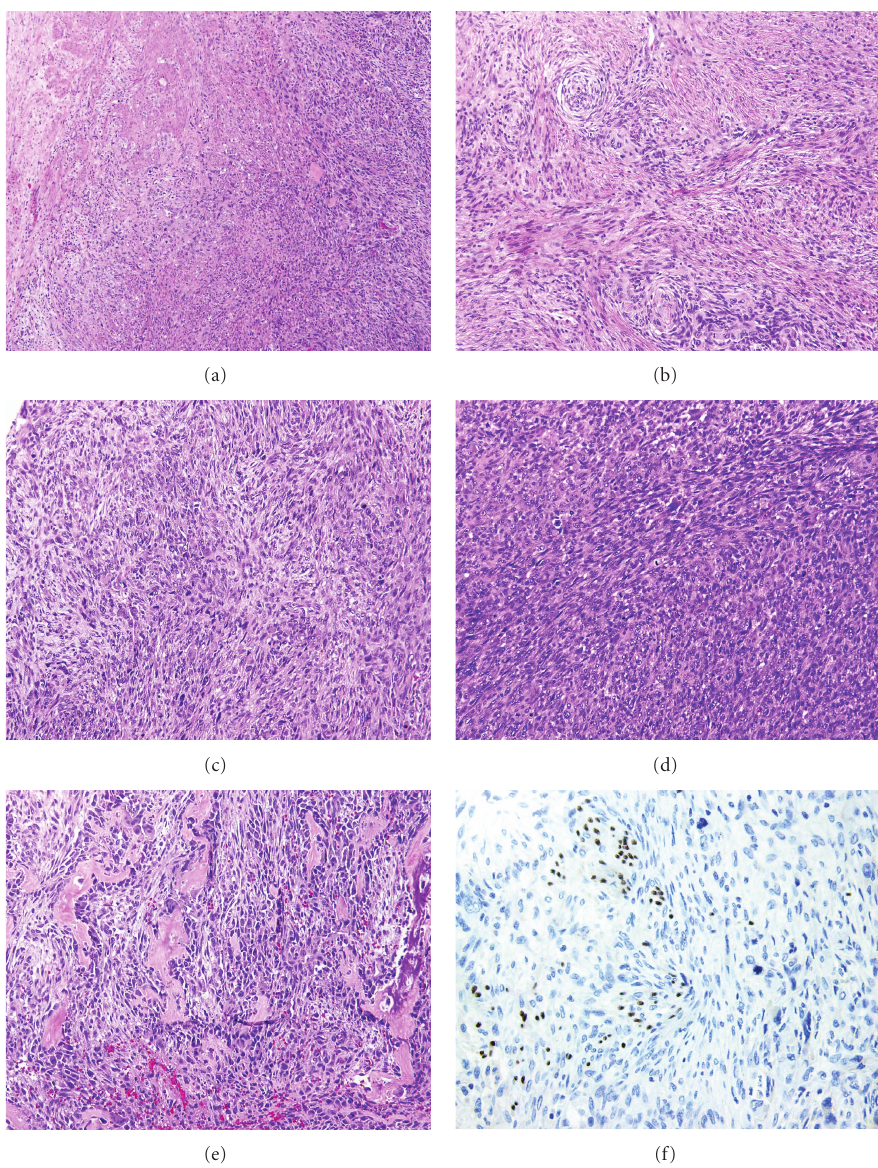
Figure 1: (a) Uterine tumor, areas of transition between the high-grade component (lower right field) and the “leiomyoma-like” areas (upper left field) (hematoxylin and eosin, original magnification × 100). (b) Uterine tumor, low-grade areas reminiscent of leiomyoma (hematoxylin and eosin, original magnification × 200). (c) Uterine tumor, High grade areas (hematoxylin and eosin, original magnification × 200). (d) Extrauterine tumor (hematoxylin and eosin, original magnification × 200). (e) Extrauterine tumor, showing osteoid formation (hematoxylin and eosin, original magnification × 200). (f) Extrauterine tumor, showing scattered cells with expression of the estrogen receptor (immunoperoxidase, original magnification ×